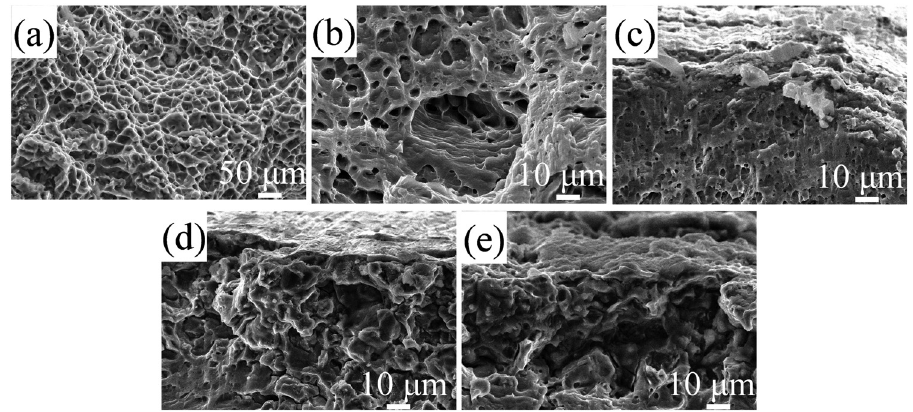
Figure 6: Microstructures of K4648 alloy after solid solution treatment: ( a ) in air condition, ( b ) in the condition of cathode potential of – 0.8 V, ( c ) in the condition of cathode potential of – 1 V, ( d ) in the condition of cathode potential of – 1.2 V, and ( e ) in the condition of cathode potential of – 1.4